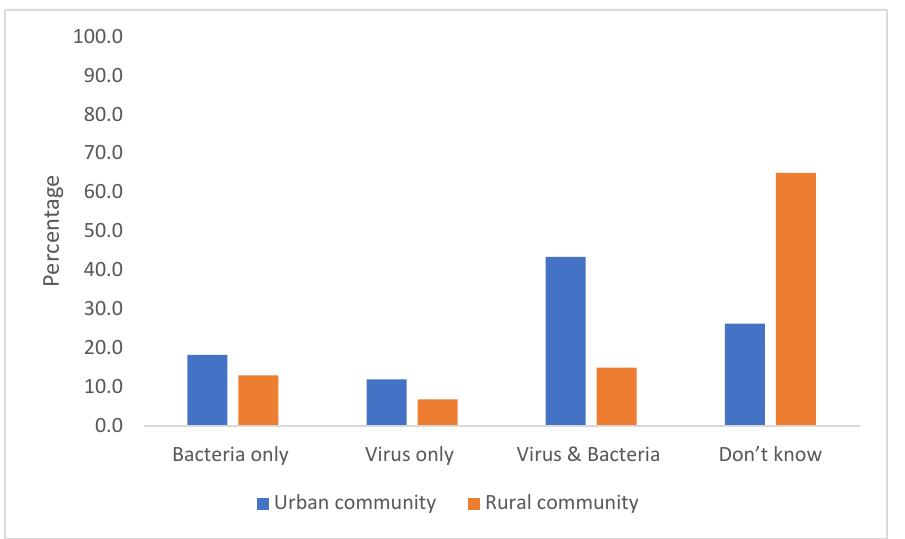
Figure 2. Responses of urban and rural respondents regarding the question “Which of the following do you think antibiotics are effective against?”.